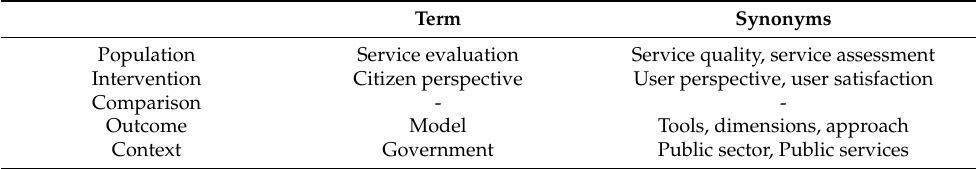
Table 2. Research terms based on the PICOC approach.